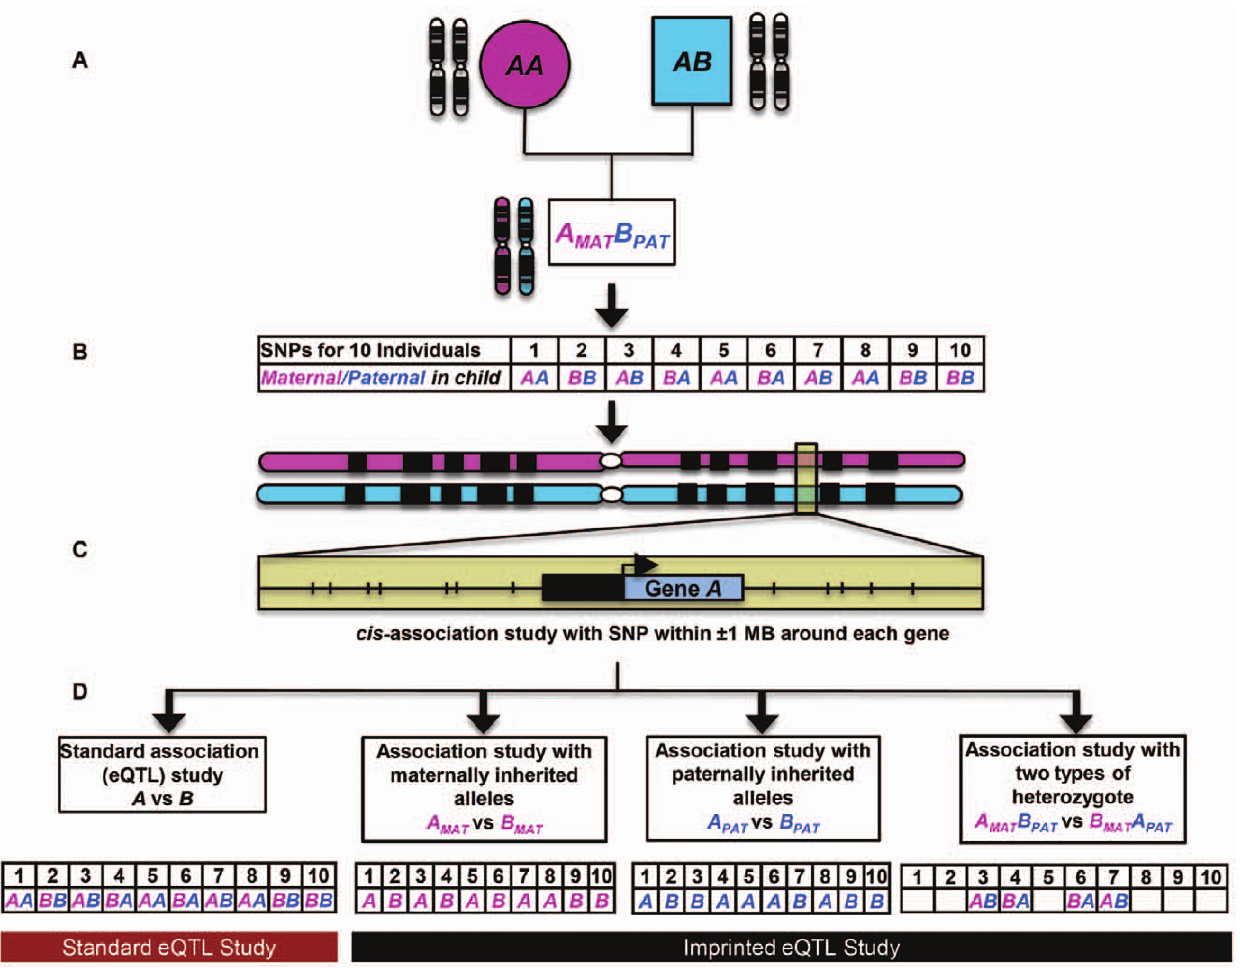
Figure 1. Example of determination of parental origin and parent-of-origin specific association testing for a hypothetical SNP. (A) For the given SNP (alleles A and B ), the homozygous mother can only contribute allele A to her offspring, which means that the child’s A allele is maternally inherited, and child’s B allele must therefore be paternally inherited. Maternal ( MAT ) and paternal ( PAT ) alleles are shown in pink and blue, respectively. (B) Example data showing annotation of parental origin of this SNP in 10 individuals. (C) cis -association study with SNPs within 6 1 MB around the gene. (D) Comparison of standard eQTL study and imprinted eQTL study (see Methods for details).